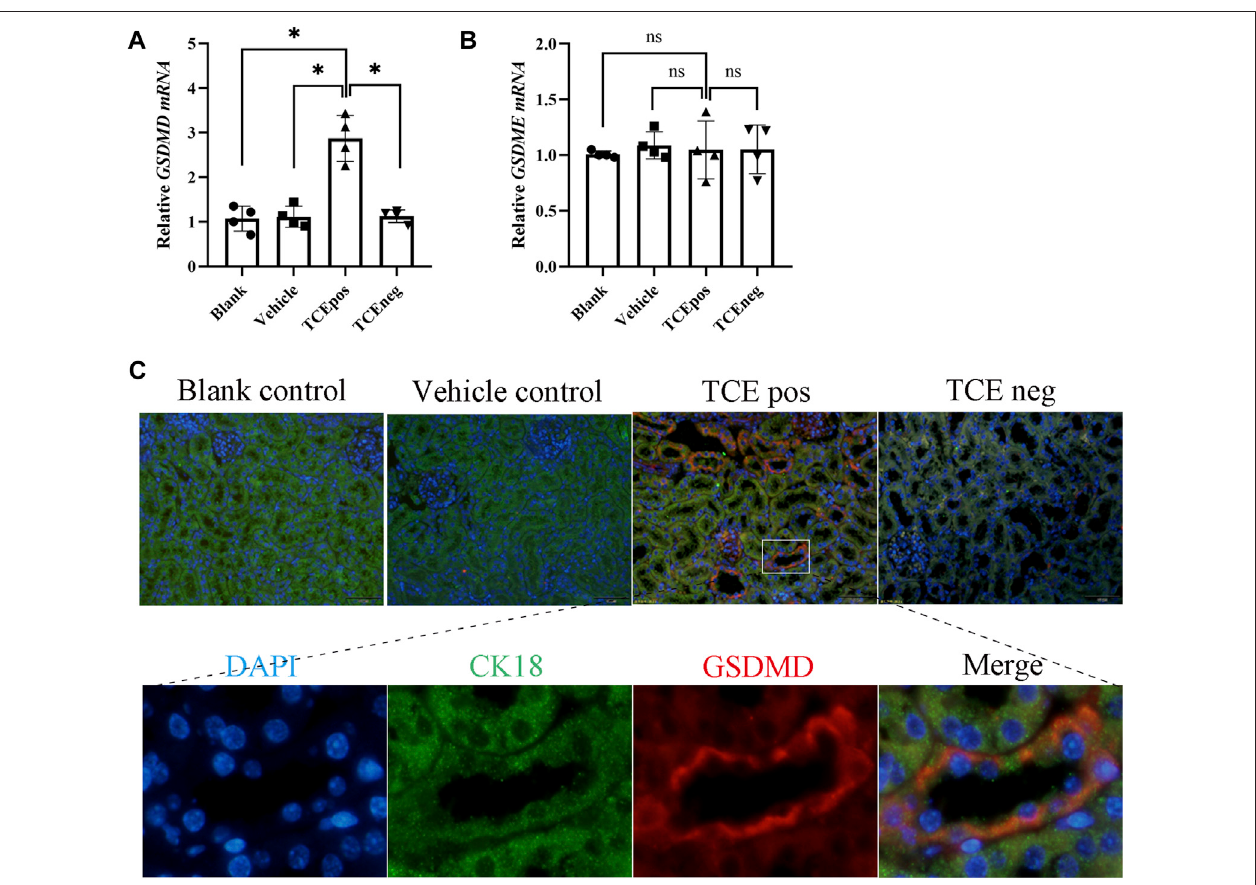
FIGURE 3 | GSDMD-mediated RTEC pyroptosis contributed to TCE-induced renal damage. (A,B) Gene levels of executive proteins of pyroptosis, including GSDMD mRNA and GSDME mRNA. (C) Colocalization of GSDMD and CK18 (a hallmark of renal tubules) by dual immuno fl uorescence staining in each group. All the scale bars represent 50 μ m.Dataarerepresentative ofthree independentexperiments andareexpressed asthemean±SD. n =3 – 5/group.Levelsofsigni fi cance were de fi ned as below: * p < 0.05.